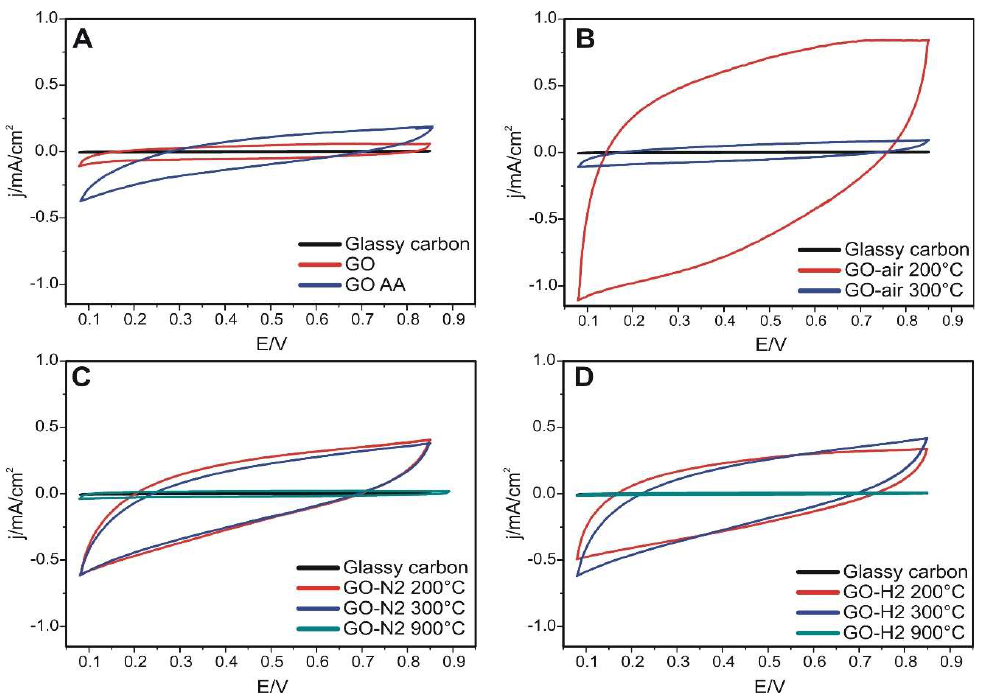
Figure 9. Cyclic voltammetry measurements for the samples in 0.5 M H 2 SO 4. ( A : samples GO and GO AA, B : samples in air, C : samples in nitrogen, D : sample in argon/hydrogen)